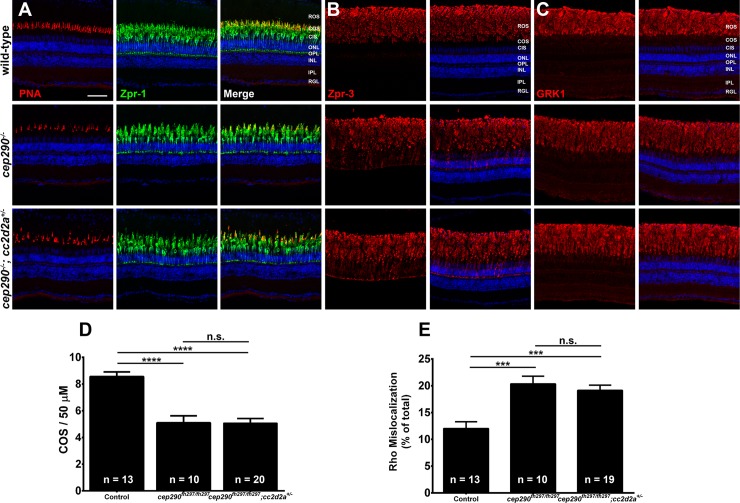
Combined loss of cep290 and cc2d2a does not exacerbate cone degeneration or rhodopsin trafficking defects.Panels show immunohistochemical analysis of dorsal retinas from wild-type (top), cep290fh297/fh297 (middle), and cep290fh297/fh297;cc2d2a+/- mutants (bottom) at 6 months of age stained with (A) PNA (red) and Zpr-1 (green) to label cone photoreceptor; (B) Zpr-3 to label rhodopsin; or (C) GRK1 to label rhodopsin kinase. ROS, rod outer segments; COS, cone outer segments; ONL, outer nuclear layer; OPL, outer plexiform layer; INL, inner nuclear layer; IPL, inner plexiform layer; RGC, retinal ganglion cells. Scale bar: 50 μm. (D) Quantification of cone outer segment density or (E) rhodopsin mislocalization from the indicated genotypes at 6 months of age. See methods section for details on quantification. Removing one allele of cc2d2a from a cep290fh297/fh297 mutant background had no effect on cone degeneration or rhodopsin mislocalization. At least 10 unique fish over at least 2 independent experiments were evaluated. *** P < 0.0005; **** P < 0.0001 as determined by a 1-way ANOVA with a Multiple Comparisons test and Tukey corrections. Data represented as means ± s.e.m.